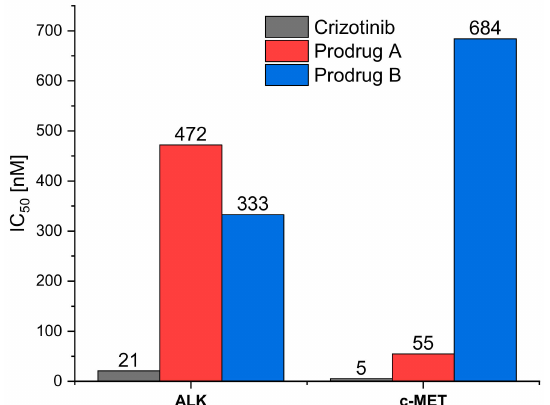
Figure 2. Diagram of the kinase inhibition potency of crizotinib compared to prodrugs A (red) and B (blue) against ALK and